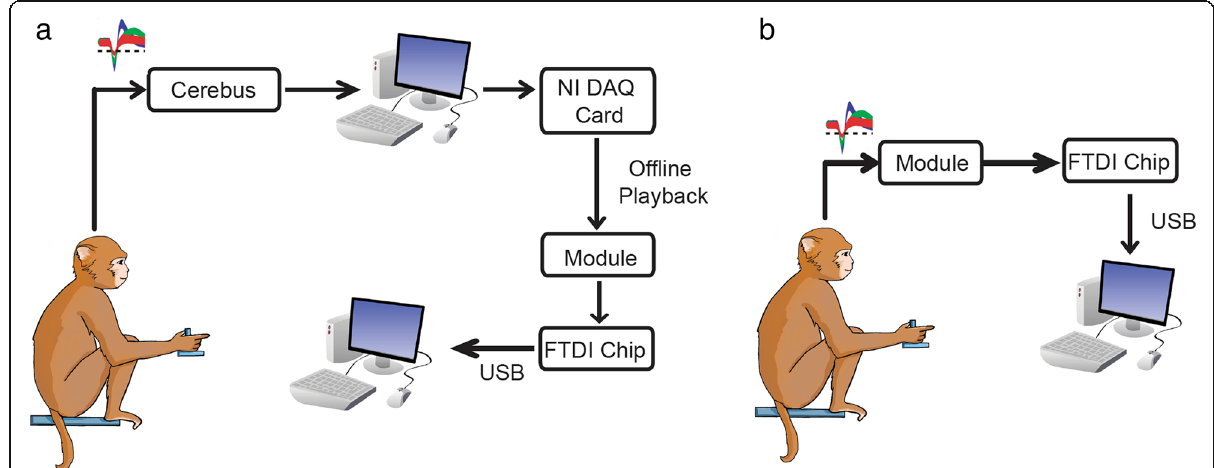
Fig. 6 Experimental Setup. a While the monkey performs the finger flexion task, broadband neural data is recorded through the Cerebus and saved on a computer. The offline data is later replayed through the module using a National Instruments DAQ card. b While the monkey sits still, neural data is recorded through the device and sent to a